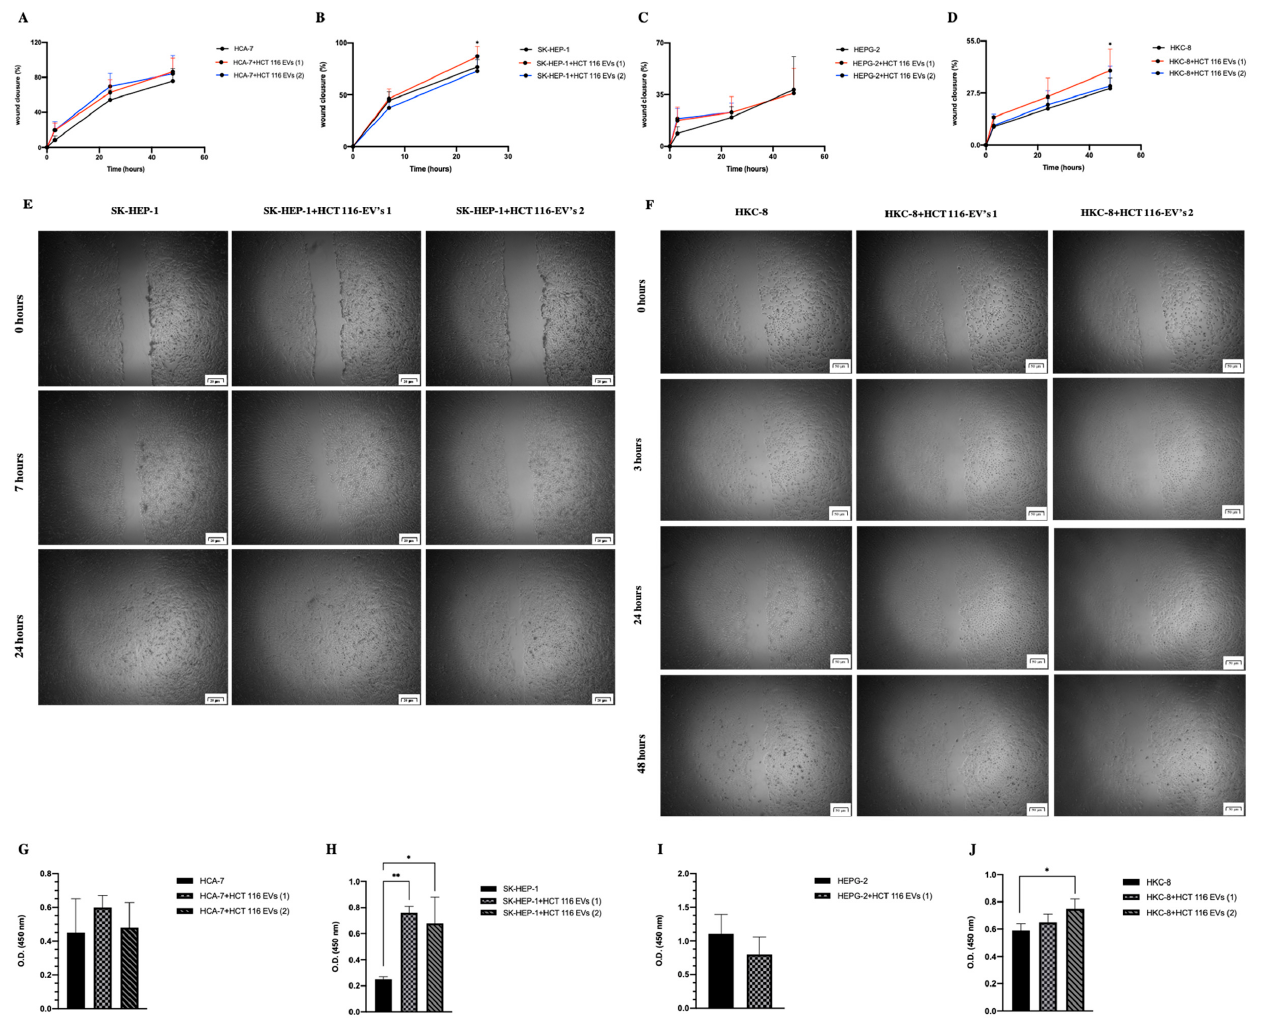
Figure 4. HCT 116-EVs’ uptake in HCA-7 ( A ), SK-HEP-1 ( B ), HEPG-2 ( C ) and HKC-8 ( D ), respectively, affects cell migration capacity of recipient cells, with HCT 116-EVs condition 1 being able to induce an increase in gap closure in SK-HEP-1 and HKC-8 recipient cells. Representative images of wound healing assay in ( E ) SK-HEP-1 and ( F ) HKC-8 cells with internalization of HCT 116-EVs (conditions 1 and 2). Additionally, the HTC 116-EVs’ uptake induces a higher proliferation rate in receptor cells SK-HEP-1 ( H ) and HKC-8 cells ( J ). However, this effect was not found in HCA-7 ( G ) or in HEPG-2 ( I ). The represented phenotypic assays were replicated three times for each sample. The statistical analysis was performed between the control group (recipient cells) and recipient cells after uptake of HCT 116-EVs (condition 1 and condition 2) in cells, at the same time point. (Mean ± Std. Error, ** p < 0.001, * p < 0.05). ( E ) Scale bar = 20 µ m; ( F ) Scale bar = 50 µ